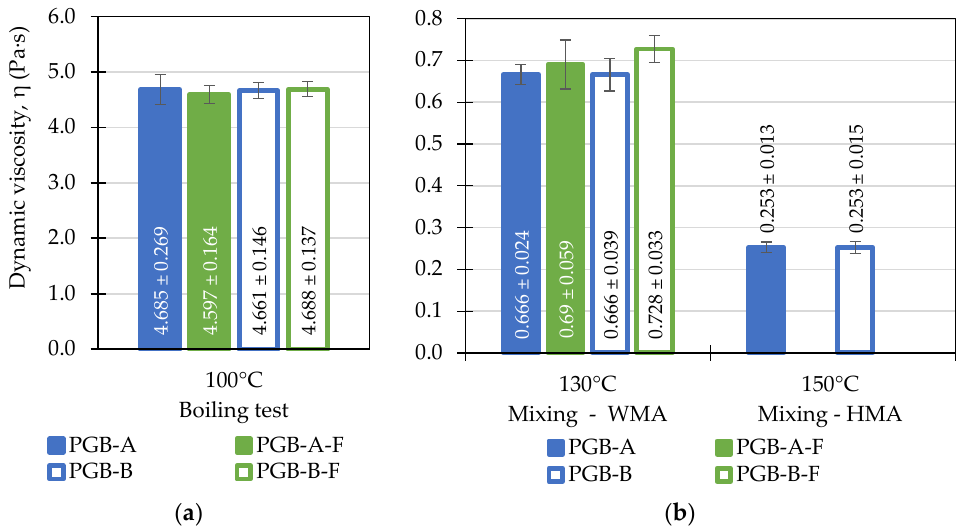
Figure 5. Results of the dynamic viscosity testing of the investigated paving-grade bitumen (PGB) before and after foaming (F) evaluated at: ( a ) 100 °C — the temperature of the boiling water stripping tests; ( b ) 130 and 150 °C — the aggregate-binder mixing temperatures.